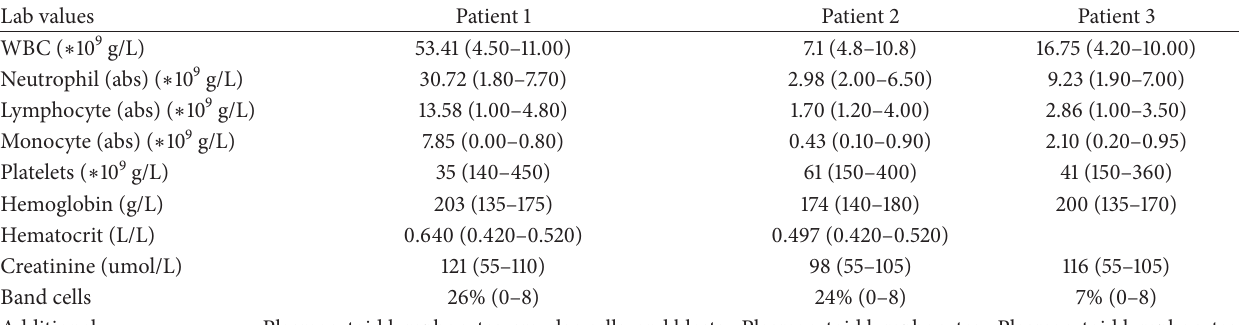
Table 1: Results of laboratory investigations on admission.